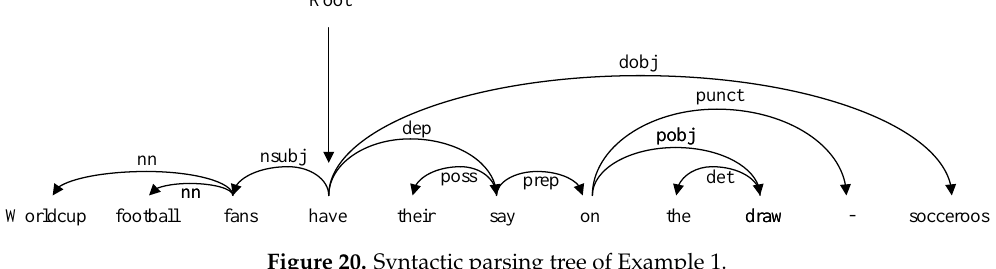
Figure 20. Syntactic parsing tree of Example 1.